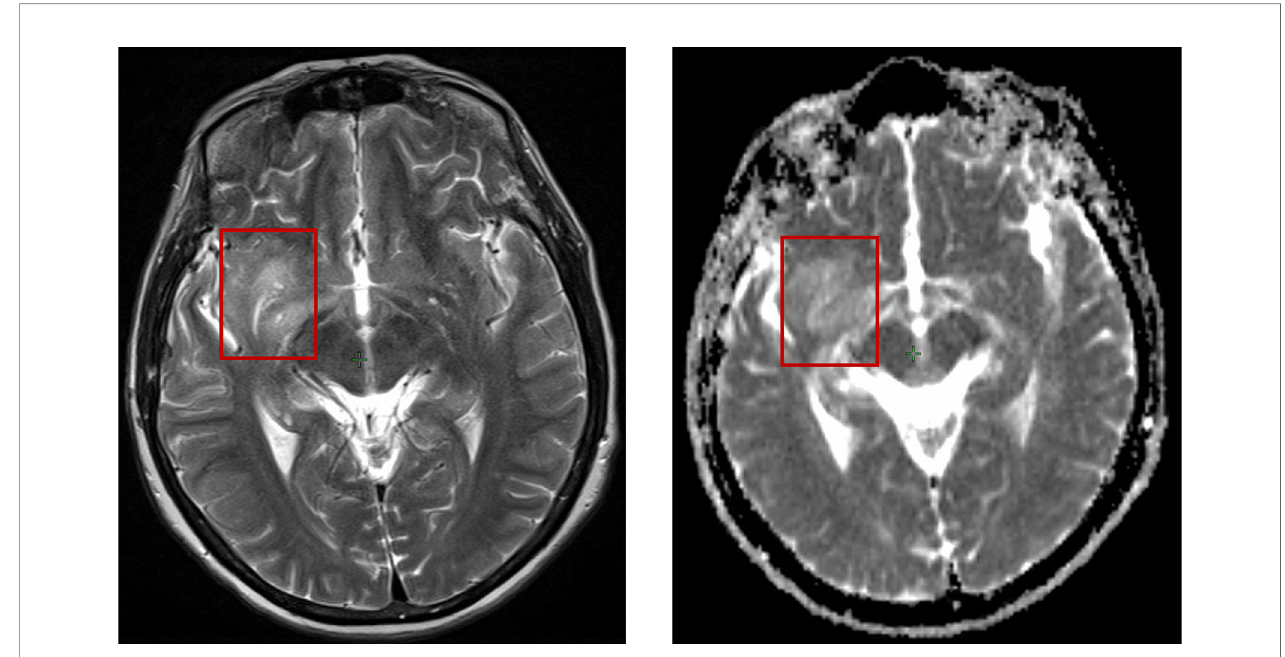
FIGURE 1 | The same patient position shown in T2 weighted MRI (left) and DW-MRI (right), where T2 MRI represents more distinguishable classi fi cation than